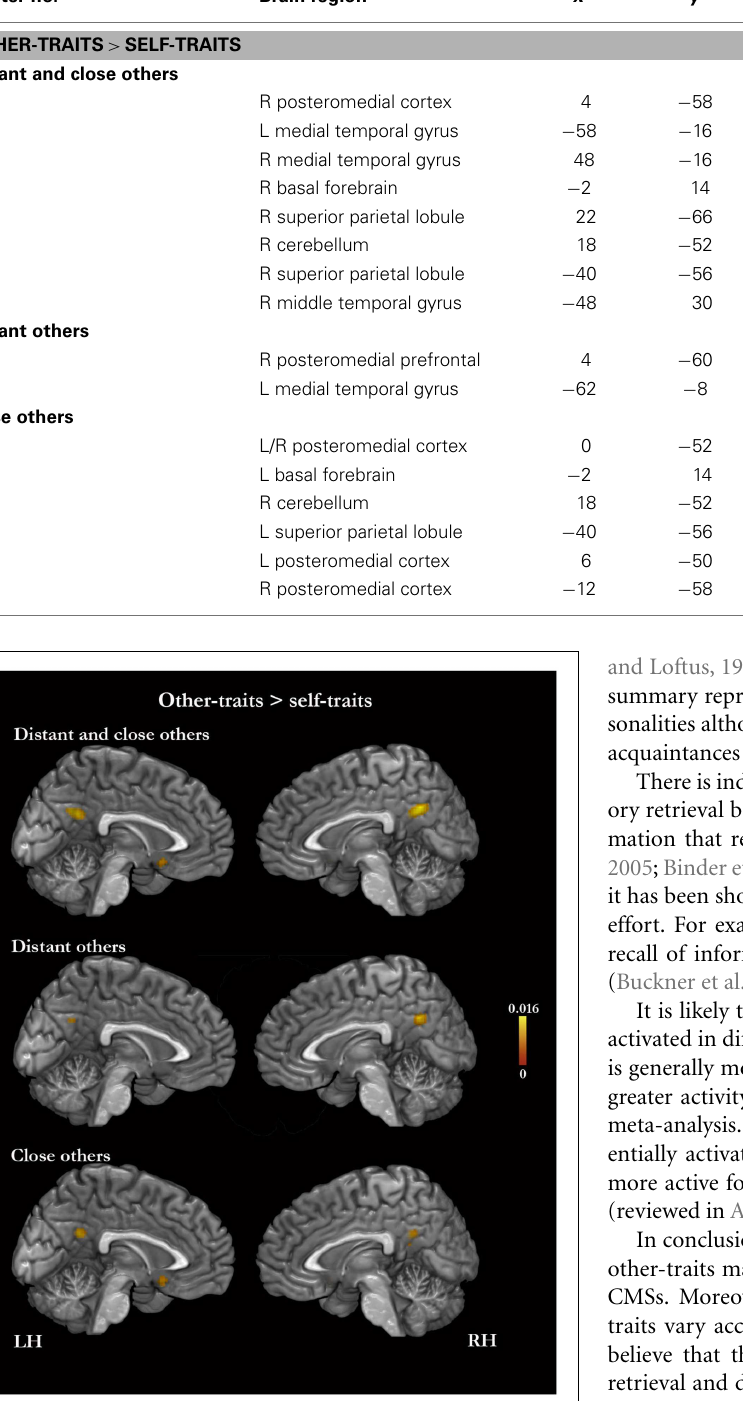
Table 5 | Meta-analysis of activation foci for other-traits compared with self-traits in relation to both kinds of other combined (61 foci; 12 experiments), to distant kinds of other (23 foci; 7 experiments), and to close kinds of other (38 foci; 6 experiments). Cluster no.